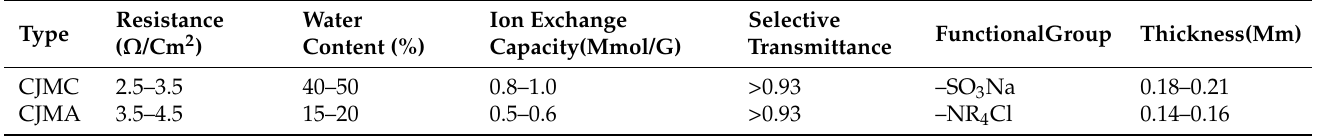
Table 1. Properties of the pristine IEMs used in the